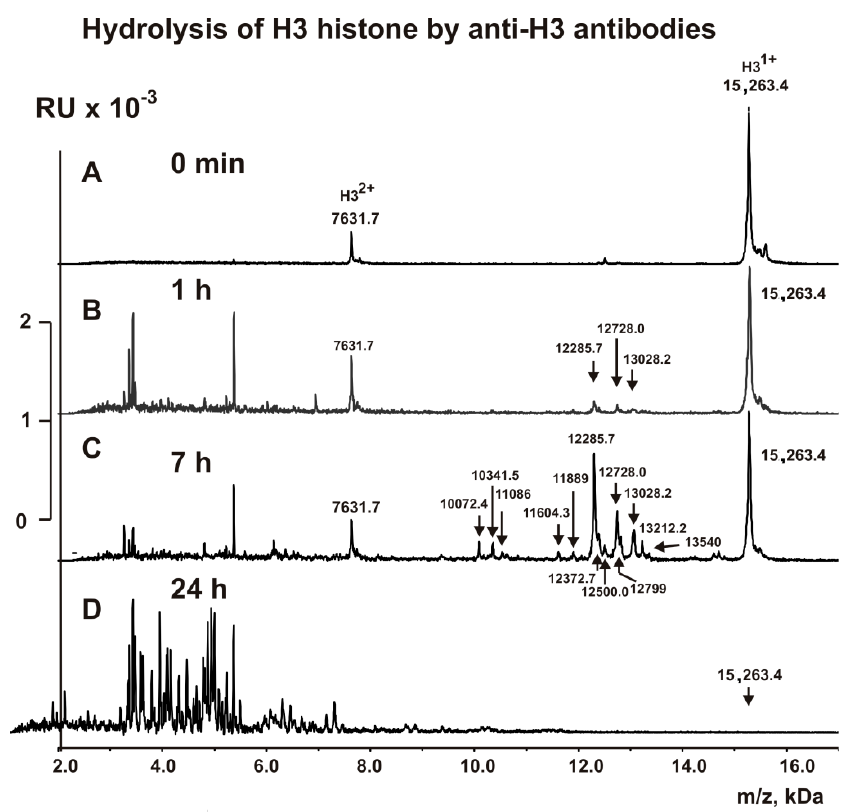
Figure 3. MALDI spectra ( A – D ) corresponding to H3 histone (1.0 mg/mL) over time hydrolysis (0– µ g/mL) 24 h) by anti-H3 IgGs (5 µg/mL) . (0–24 h) by anti-H3 IgGs (5